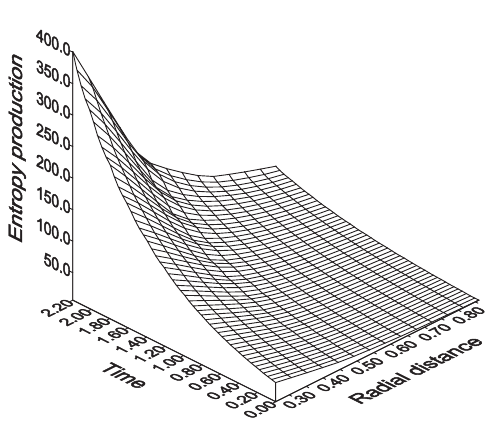
Figure 4.7 . Variation of the entropy production with radial distance and time. X 1